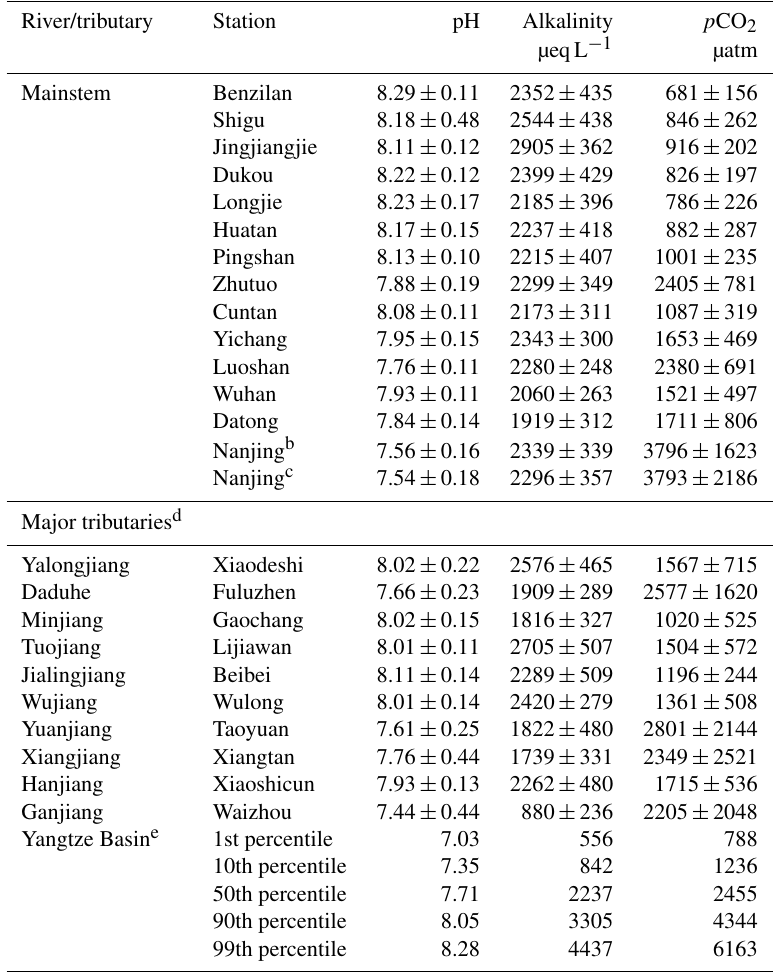
Table 2. Riverine pH, alkalinity, and p CO 2 in the Yangtze River basin (median ± standard deviation) a